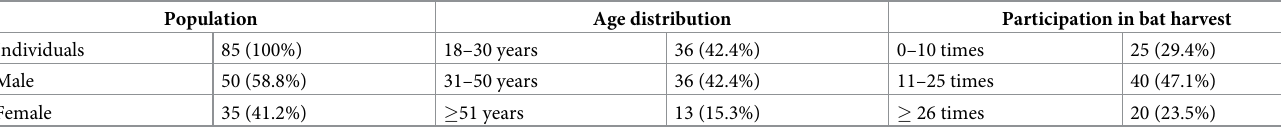
Table 2. Basic demographic information on human study population.